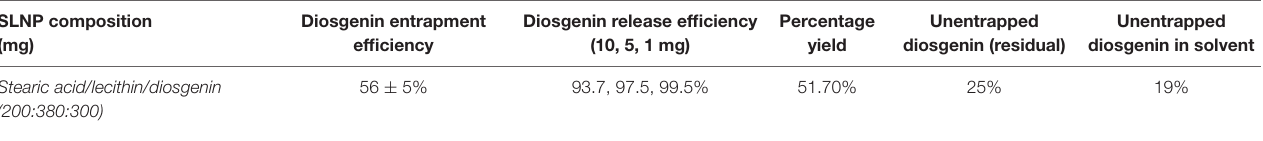
TABLE 1 | SLNP efficiency of entrapment, release of diosgenin, and yield of diosgenin SLNP has been quantified with HPLC. SLNP composition